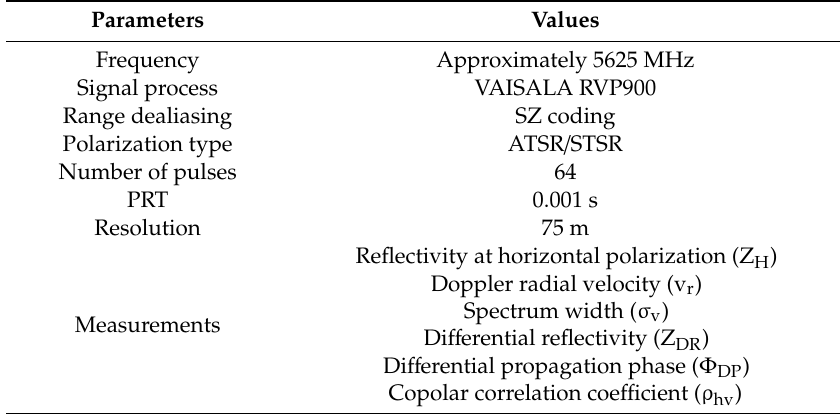
Table 1. Main system characteristics and scan parameters for Nanjing University C-band polarimetric Doppler weather radar